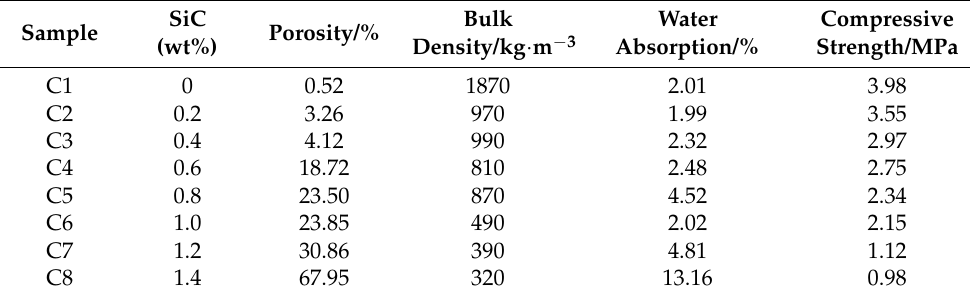
Table 2. Influence of SiC on properties of